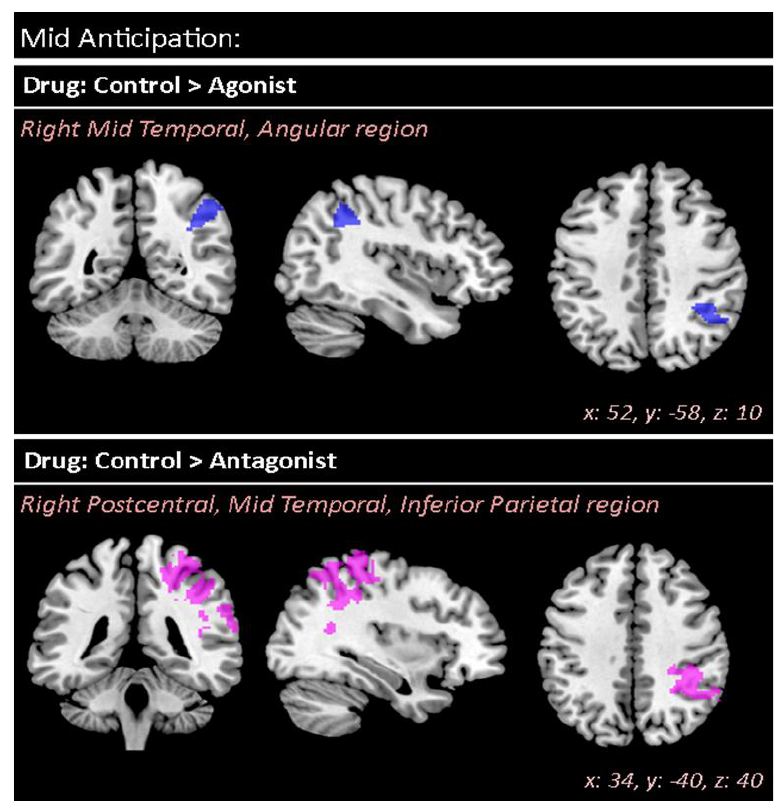
Figure 3. Source estimates during mid-anticipation for Control versus agonist (Cabergoline) and antagonist (Amisulpride). The time window of mid anticipation [ − 1500–1000 ms] was baseline corrected to [ − 2500–2000 ms]. Clusters are shown at FWE correction and regions labelled using the AAL2 atlas. The agonist (blue) reduced activity within the right mid-temporal and angular regions in contrast to the control. The antagonist (pink) reduced activity within the right postcentral, mid- temporal, and inferior parietal regions. The xyz position of the slices are aligned with the peak-voxel at peak-level inference and reported in mm according to the MNI atlas. In comparison to the control, the agonist reduced activity within the right mid temporal and angular regions, and the antagonist reduced activity within the right postcentral, mid temporal, and inferior parietal region.